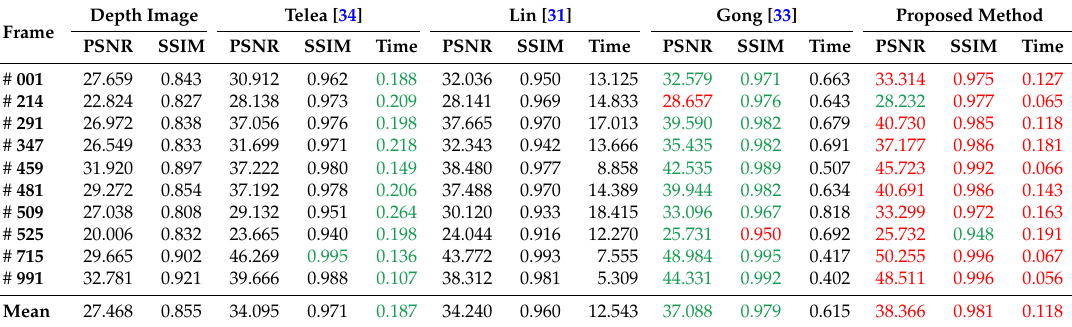
Table 2. Quantitative evaluation results on the selected Tsukuba Stereo Dataset. Red text indicates the best, and green text indicates the second best performance. PSNR, peak signal-to-noise ratio; SSIM, structural